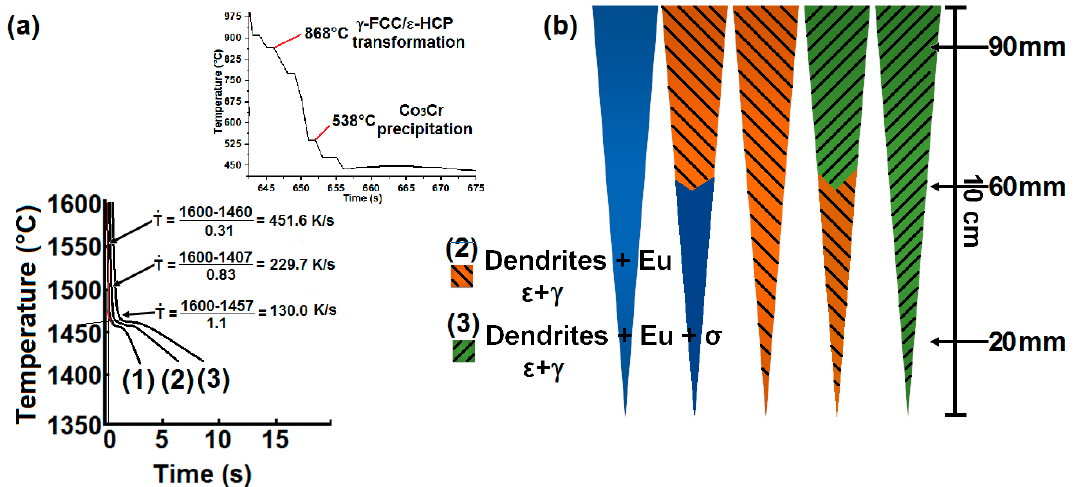
Figure 2. ( a ) Representative cooling curves exhibited at various locations. (1) Tip, (2) middle, (3) top (3) top in a chill-cast wedge of Co-20 wt. %Cr alloy. In the inset two solid state events can be in a chill ‐ cast wedge of Co ‐ 20 wt. %Cr alloy. In the inset two solid state events can be seen: (1) the seen: (1) the martensitic transformation at 868 ◦ C; and (2) Co 3 Cr precipitation at 538 ◦ C; ( b ) exhibited martensitic transformation at 868 °C, and (2) Co 3 Cr precipitation at 538 °C; ( b ) exhibited microstructures for the Co-20, 30, 35, 40, and 44 wt. % Cr, along the wedge-shaped microstructures for the Co ‐ 20, 30, 35, 40, and 44 wt. % Cr, along the wedge ‐ shaped ingot.